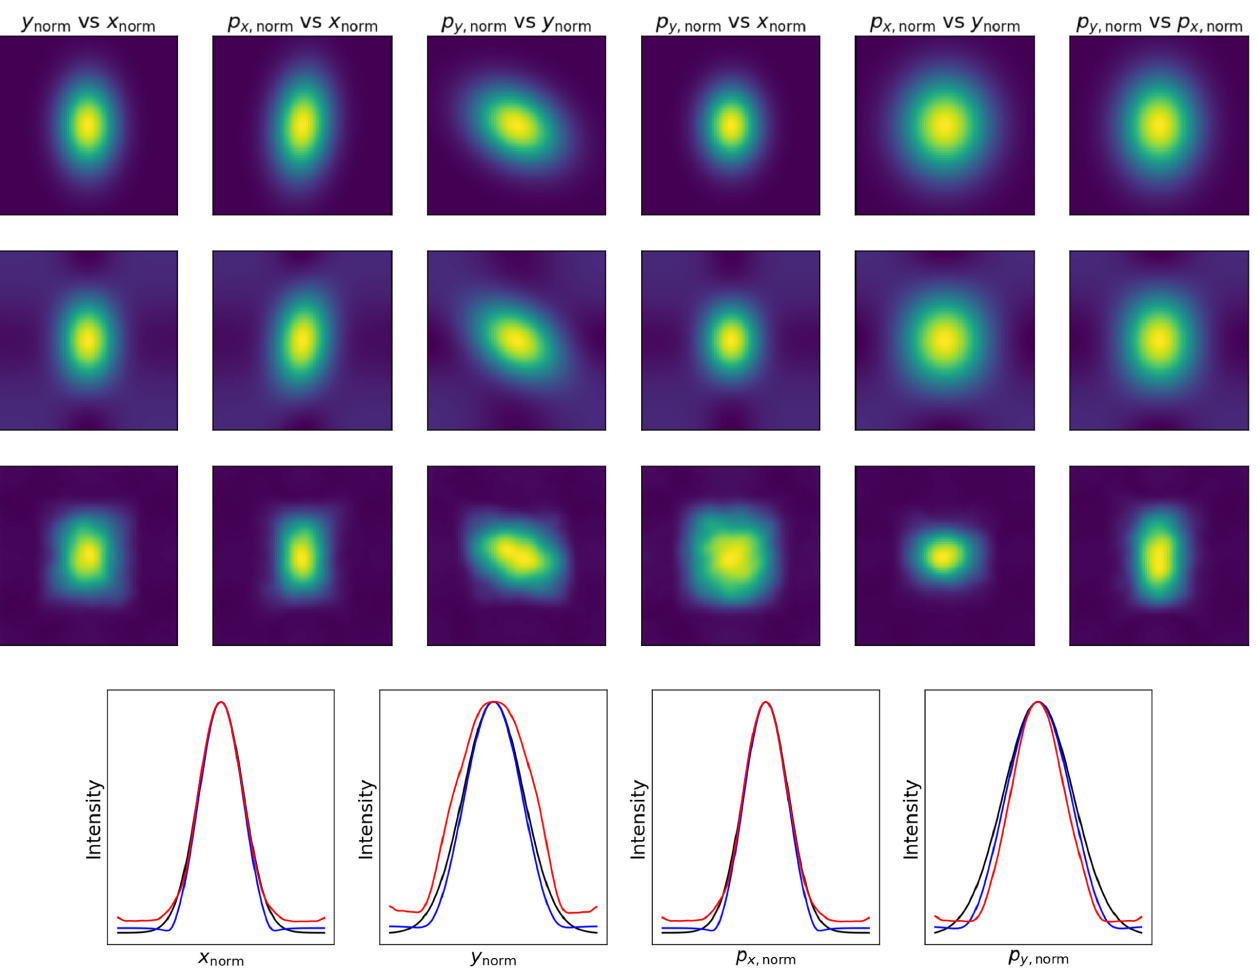
FIG. 10. Comparison of phase space projections between an original simulated phase space based on a simple Gaussian distribution (top row); the distribution reconstructed after compression and decompression using a discrete cosine transform (second row); and reconstruction, using a trained neural network, from images obtained from simulation of a quadrupole scan (third row). The bottom row shows 1D projections of the distribution onto the phase space axes, for the original distribution (black line), the distribution after DCT compression and decompression (blue line), and the distribution reconstructed using the neural network (red